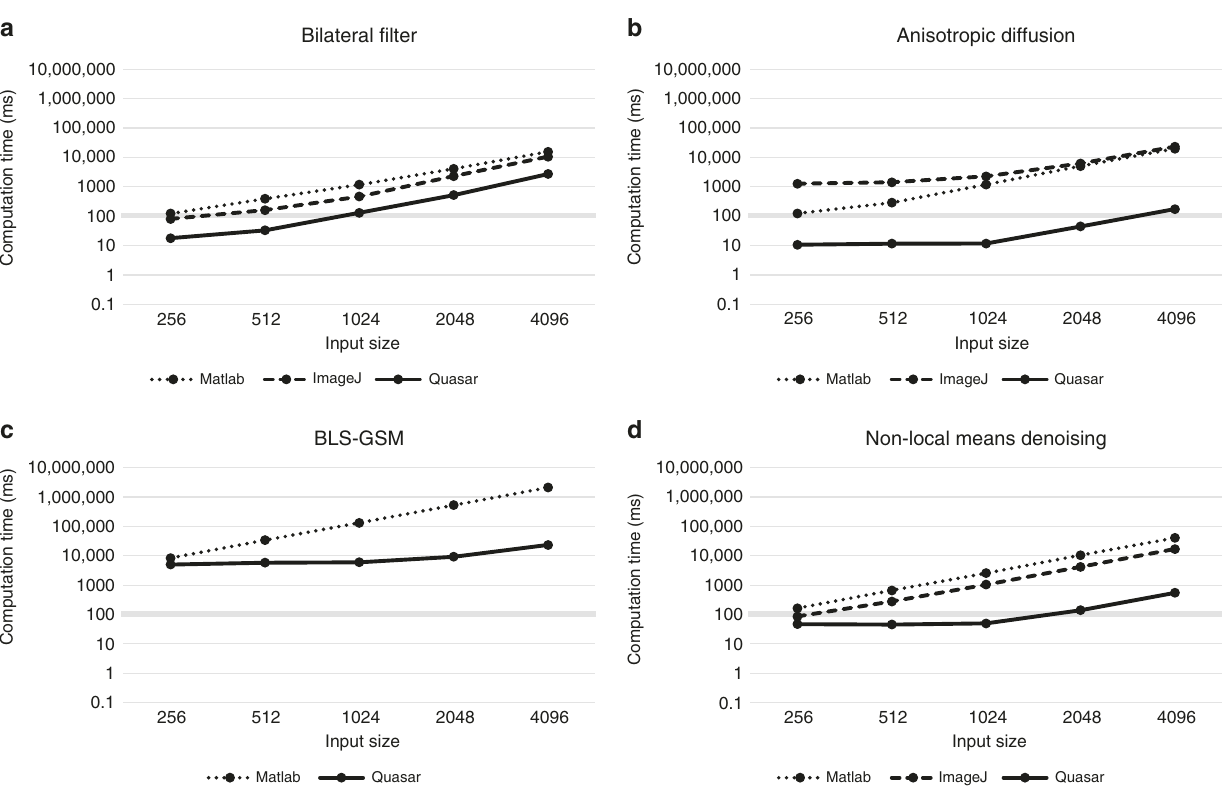
Fig. 9 Computational performance comparison of Quasar-based and alternative available implementations. Absolute computational performance (in milliseconds) of ( a ) bilateral fi ltering 41 , ( b ) anisotropic diffusion 38 , ( c ) BLS-GSM 14 , and ( d ) nonlocal means denoising 16 for different input sizes. A comparison is made between our proposed GPU-based Quasar framework and alternative implementations that are available to the scienti fi c community: bilateral fi lter (ImageJ 52 and MATLAB 53 based), anisotropic diffusion (ImageJ 54 and MATLAB 55 based), BLS-GSM (MATLAB 56 ) and nonlocal means denoising (ImageJ 57 and MATLAB 58 based). For each algorithm, we consider inputs of 256 2 , 512 2 , 1024 2 , 2048 2 , and 4096 2 pixels. In general, our Quasar implementation performs 10 to 100 times faster compared with the existing software packages. Notice that the obtained speedup increases as the input image size increases due to the fact that GPUs are able to process more pixels in